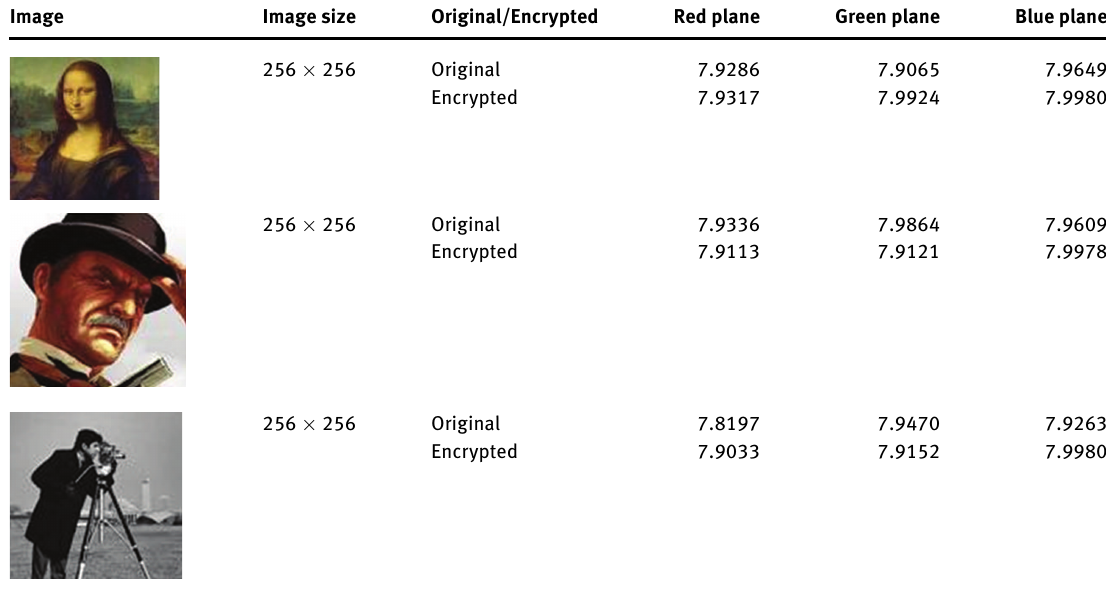
Table 2: Information Entropy for Original and Cipher Images.